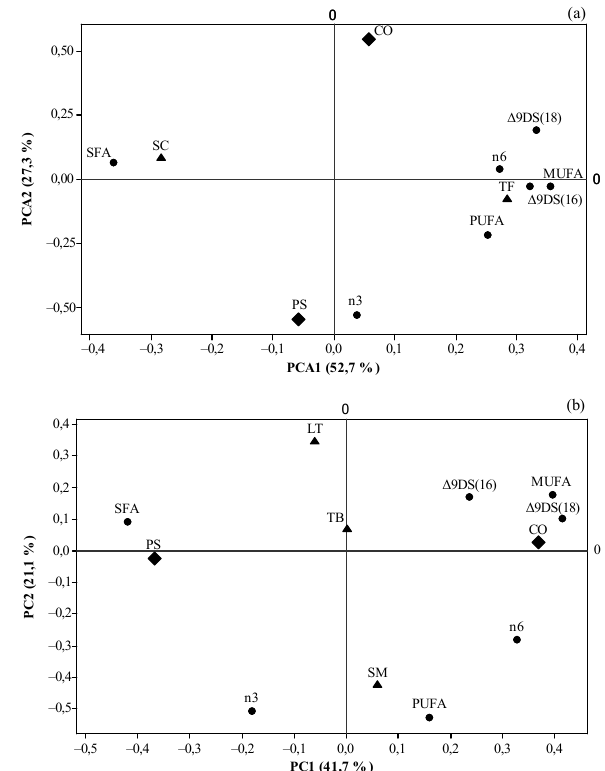
Figure 1. Principal component analysis for some fatty acid groups and indexes (●) of fat depots (a) and intramuscular fat (b) (▲) in different feeding systems ( ♦ ). CO: Concentrate lambs, PS: Pasture lambs; SC: subcutaneous , TF: tail fat, LT: longissimus thoracis ), SM: semimembranosus , TB: triceps brachii ; SFA: Saturated fatty acids, MUFA: Monounsaturated fatty acids, PUFA: Polyunsaturated fatty acids; Δ9DS(18): Δ9-desaturase (C18) index, Δ9DS(16): Δ9-desaturase (C16) index.